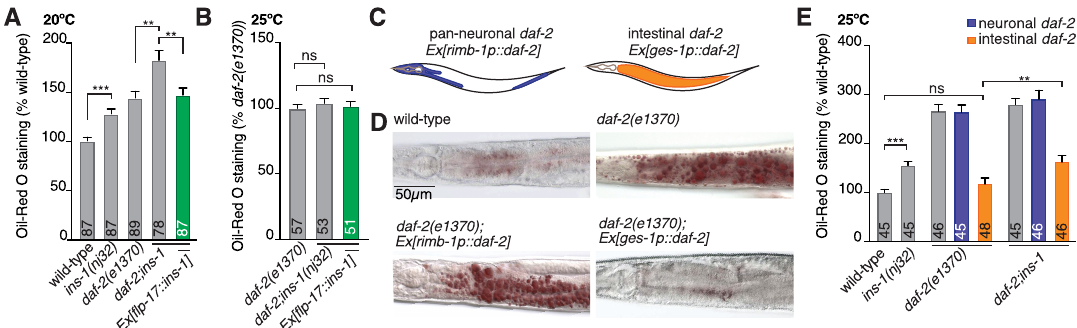
Fig 6. INS-1 acts from the BAG neurons to control intestinal DAF-2 activity. (A) ORO quantification of wild-type, ins-1(nj32) and daf-2(e1370) single mutants and the daf-2(e1370); ins-1(nj32) double mutant in the presence or absence of Ex[flp-17p :: ins-1cDNA] . Assayed at daf-2(e1370) semi-permissive temperature of 20˚C. (B) ORO quantification of daf-2(e1370) single mutants and the daf-2 (e1370); ins-1(nj32) double mutant in the presence or absence of Ex[flp-17p :: ins-1cDNA] . Shifted to the daf-2(e1370) restrictive temperature 25˚C for 24 hours prior to assaying. (C) Schematic diagrams showing where daf-2 is expressed under the rimb-1 (pan- neuronal) and ges-1 (intestinal) promoters. (D) Representative ORO images of wild-type, daf-2(e1370) , daf-2(e1370); Ex[rimb-1p :: daf-2a] (neuronal daf-2a expression) and daf-2(e1370); Ex[ges-1p :: daf-2a] (intestinal daf-2a expression) animal shifted to 25˚C for 24 hours prior to staining. Scale bar 50 μ m. (E) ORO quantification of wild-type, ins-1(nj32) and daf-2(e1370) single mutants and the daf-2(e1370); ins-1 (nj32) double mutant with neuronal (blue bars) and intestinal (orange bars) expression of daf-2a cDNA. All data presented as � x + SEM, n shown in bar. Significance assessed by 1-way ANOVA (Tukey’s correction). ns, not significant ( p > 0.05), � = p � 0.05, �� = p � 0.01, ��� = p � 0.001. The underlying numerical data can be found in S1 Data. ORO, Oil-Red O.